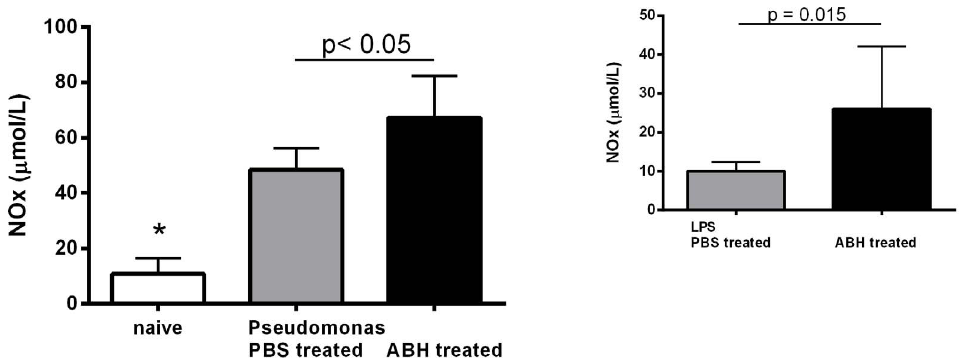
Figure 3. Nitric oxide metabolite (NOx) concentrations in mouse lung homogenates of untreated (naı¨ve) control as well as Pseudomonas infected mice treated with PBS or the arginase inhibitor 2(S)-amino-6-boronohexanoic acid (ABH). Concentrations were significantly different between groups (p , 0.0001, ANOVA). NOx levels in lung were lower in naı¨ve compared to Pseudomonas infected and PBS treated mice (*: p , 0.001, Mann-Whitney test). ABH treatment resulted in a significant increase in ABH vs. PBS treated animals (p , 0.05, Mann-Whitney test). A similar increase in lung NOx after ABH treatment was seen in mice after intratracheal instillation of lipopolysaccharide (LPS) (p=0.015, t-test).